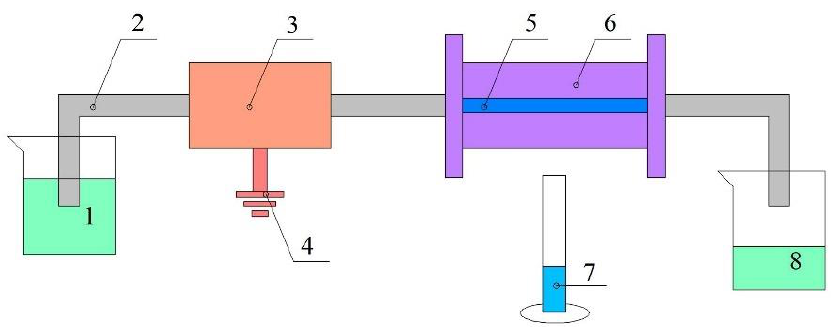
Figure 1. The setup diagram of the manganese oxide/PTFE HFM degradation: (1) p-aminophenol solution or deionized water; (2) silicone tube; (3) peristaltic pump; (4) power supply; (5) MnO 2 /PTFE or Mn 3 O 4 /PTFE HFM; (6) supporter; (7) osmotic solution; (8) p-aminophenol solution or deionized water.